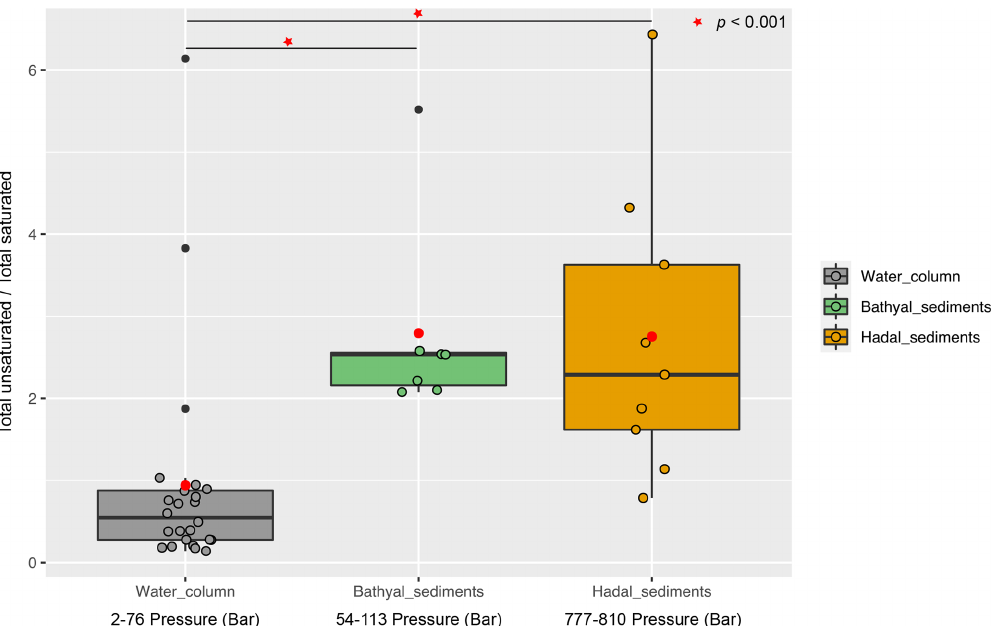
Figure 5. Boxplot showing the ratio of total unsaturated fatty acids to total saturated fatty acids derived from IPLs present in water-column samples (Cantarero et al., 2020) and sediments of the Atacama Trench (this study). Red circles indicate the average value in each environment. The Wilcoxon test ( p value < 0 . 001) indicates that sediments have statistical ratios higher than the water column (horizontal lines and red